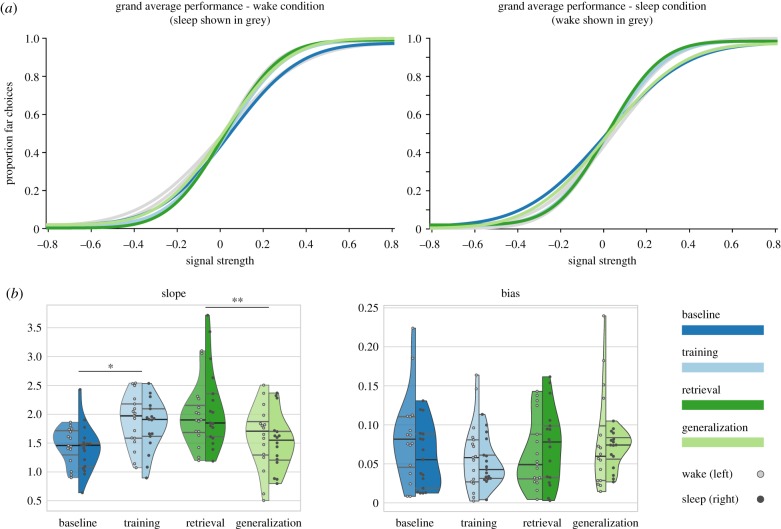
Performance of participants improved across task execution. (a) Grand average psychometric functions generated by fitting cumulative Gaussians to each subject's responses and averaging the resulting fitting parameters across subjects. For each condition (left: wake; right: sleep), Training and Retrieval exhibit a noticeably steeper slope compared to the other phases. (b) For each subject, condition and phase, model parameters were extracted to evaluate and compare performance. Performance improvements were reflected by significant main effects of Phase for the model parameter Slope (p < 0.001, other parameters reported in the main text), with performance improvements from Baseline to Training and performance deteriorations from Retrieval to Generalization. There was no significant change across phases in participants' bias and no significant difference between wake and sleep conditions. Violin plots show median, upper and lower quartile, extend to the most extreme values, and are vertically split to show the wake (left; light dots show individual subjects) and sleep (right; dark dots) conditions, respectively. **p < 0.01; *p < 0.05.